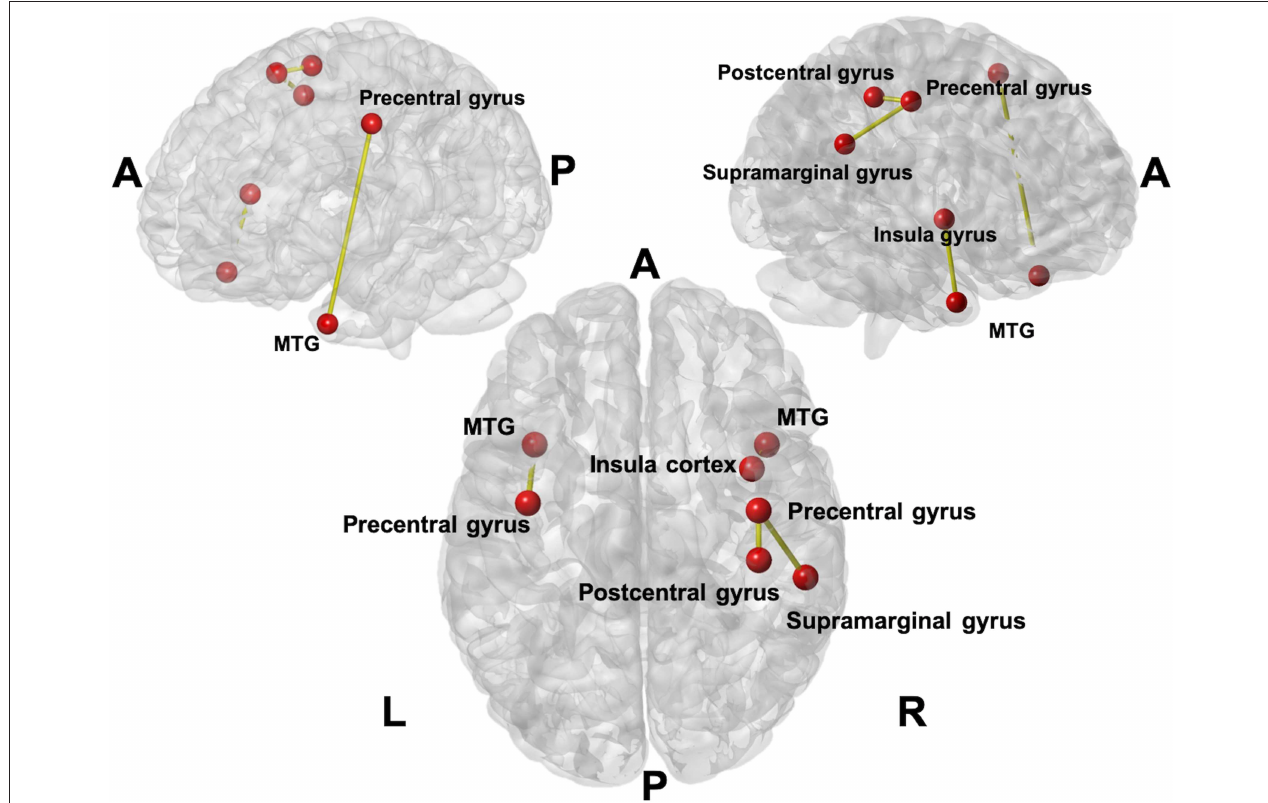
FIGURE 2 | The links with the significant difference in changes between acupuncture and control groups in terms of the changes in functional connectivity between two visits. Four connections (seven anatomical regions were affected) were found with increased connectivity in the acupuncture group. The involved connections included the connection between the Middle Temporal Gyrus (MTG) and precentral gyrus on the left; postcentral gyrus and precentral gyrus on the right; supramarginal gyrus and precentral gyrus on the right, and MTG and insula cortex on the right.